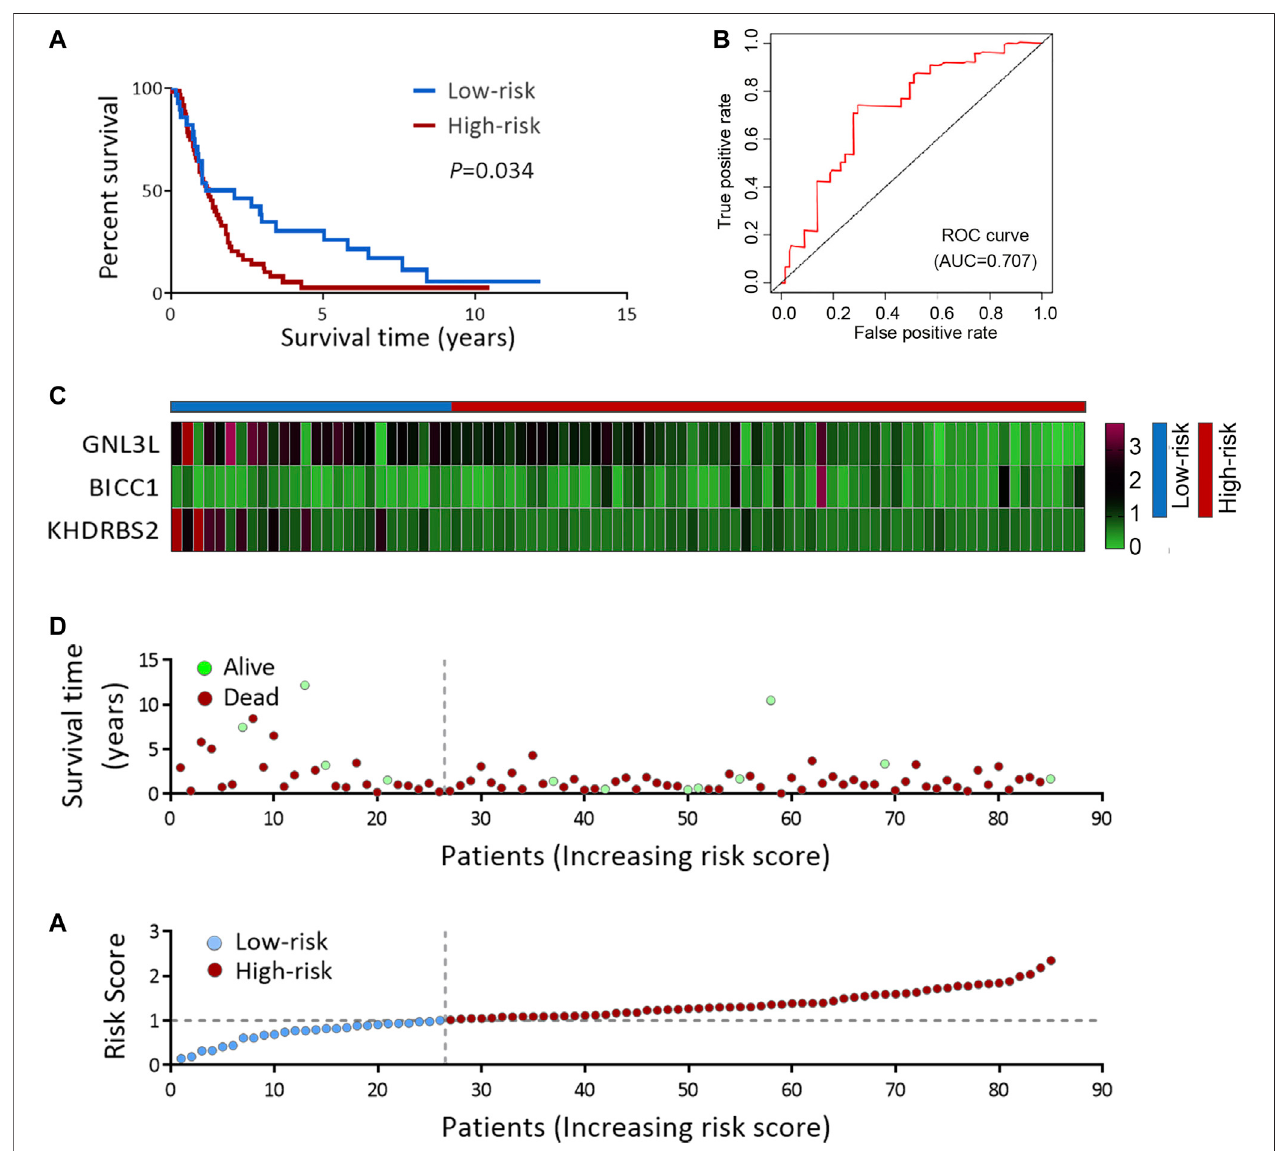
FIGURE 6| Risk score analysis of3-genes prognostic model in CGGAcohort. (A) OS analysis among CGGA GBM patients strati fi ed by risk score. (B) ROC curve forforecastingOSbasedonriskscore. (C) Expression heatmap ofthe3hubRBPs. (D) SurvivalstatusoftheCGGA GBMpatients. (E) Theriskscorevaluesinlow-and high-risk subgroups. OS, overall